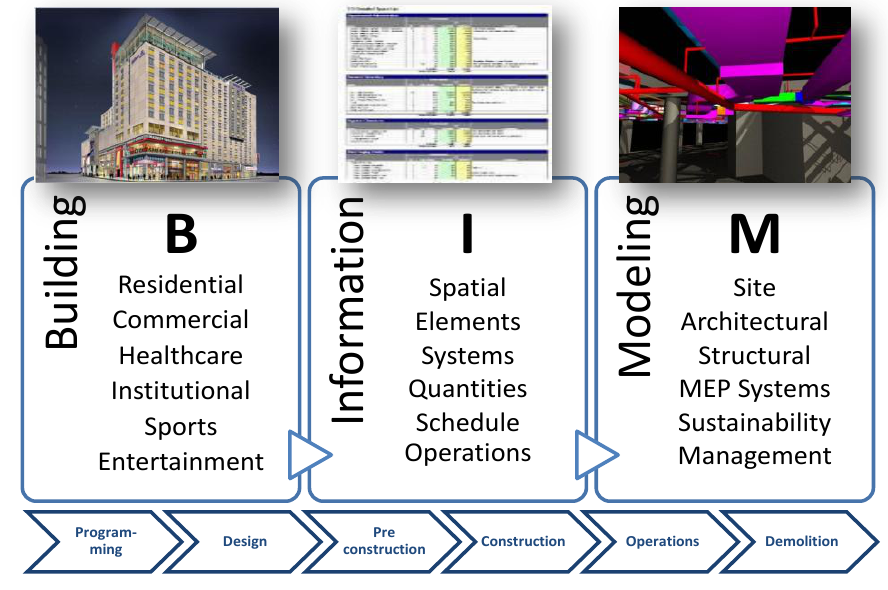
Figure 1 A Visual Representation of BIM